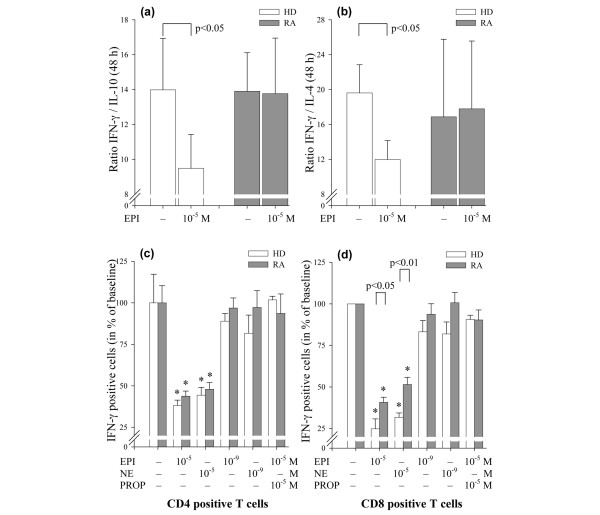
Influence of catecholamines on cytokine ratios and intracellular interferon (IFN)-γ expression in healthy donors (HDs) (white bars) and patients with rheumatoid arthritis (RA) (gray bars). The ratios between the raw cytokine values of (a) IFN-γ and interleukin (IL)-10 (n = 16) or (b) IFN-γ and IL-4 (HDs: n = 6; patients with RA: n = 5) were evaluated after stimulation of T cells for 48 hours with medium and 10-5 M epinephrine (EPI), respectively. Intracellular IFN-γ was determined in (c) CD4-positive and (d) CD8-positive T cells activated for 12 hours. The baseline values of IFN-γ-positive cells in the CD4 and CD8 T-cell populations of each RA patient and HD were defined as 100%, and the number of IFN-γ-positive cells upon co-incubation with catecholamines related to the baseline values of each HD and patient with RA. *p < 0.05 as compared with the values obtained upon control conditions. NE, norepinephrine; PROP, propranolol.